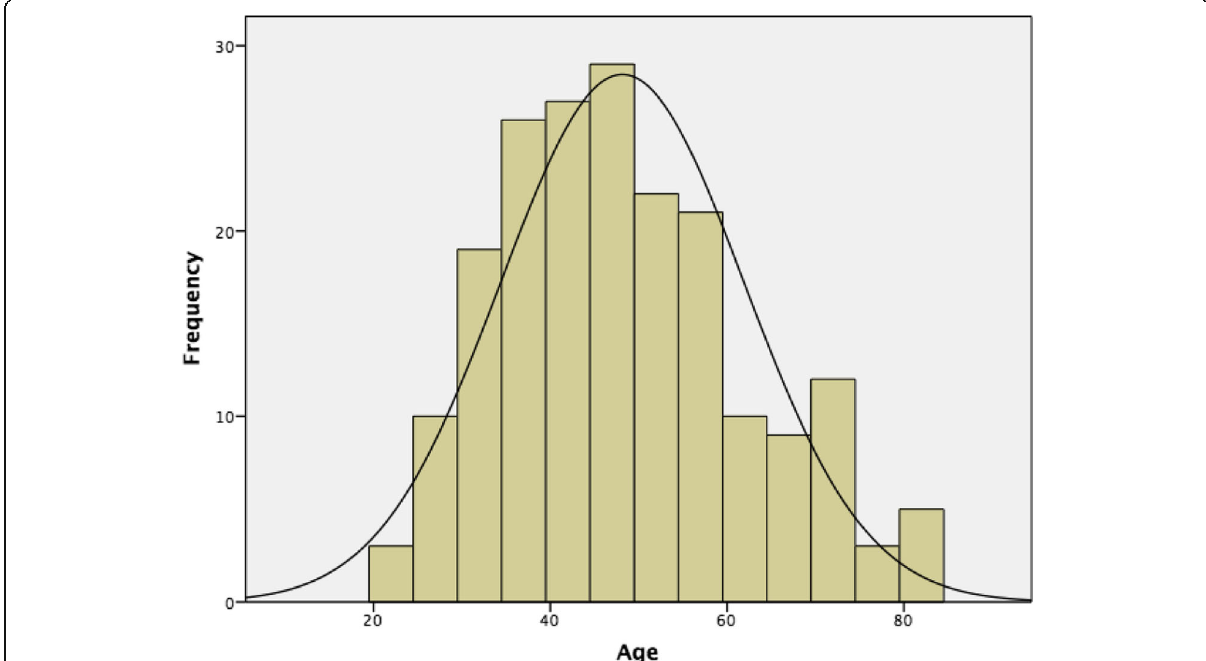
Fig. 3 Age distribution of men > 18 years with hydrocoele that underwent surgery